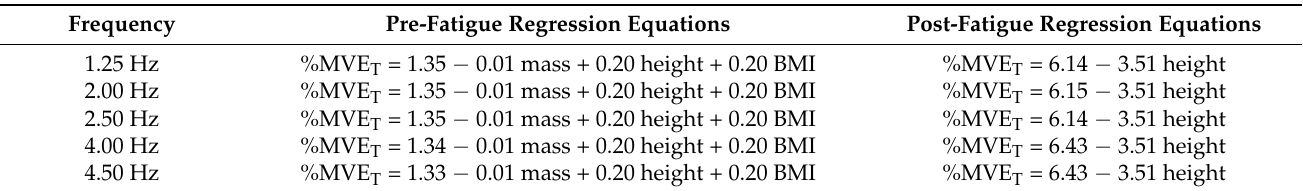
Figure 3. Fits vs. %MVE T (transformed % maximum voluntary electrical activation data) ( a ) before and ( b ) after back muscle fatigue from the stepwise regression models of the external oblique (EO). Table 3. Stepwise regression models for %MVE T (transformed % maximum voluntary electrical activation data) of the external oblique pre- and post-back muscle fatigue, where mass, height, and body mass index (BMI) are continuous predictors, and vibration frequency is a categorical predictor.